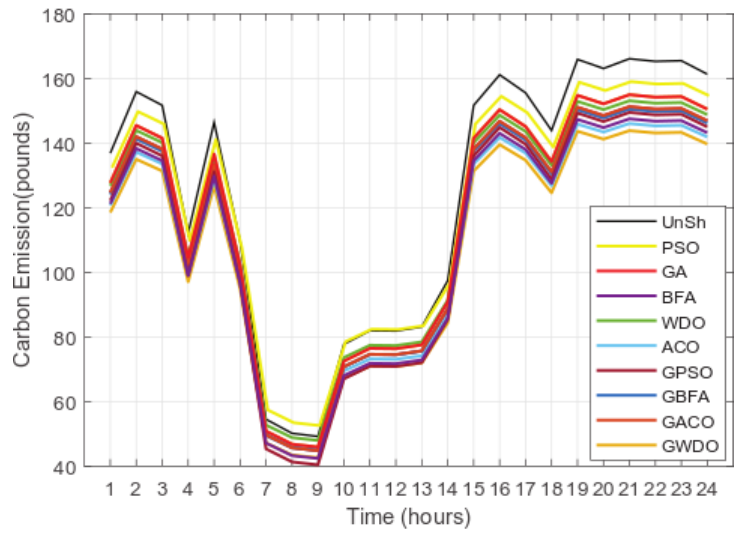
Figure 7. Case study 1: Carbon emission